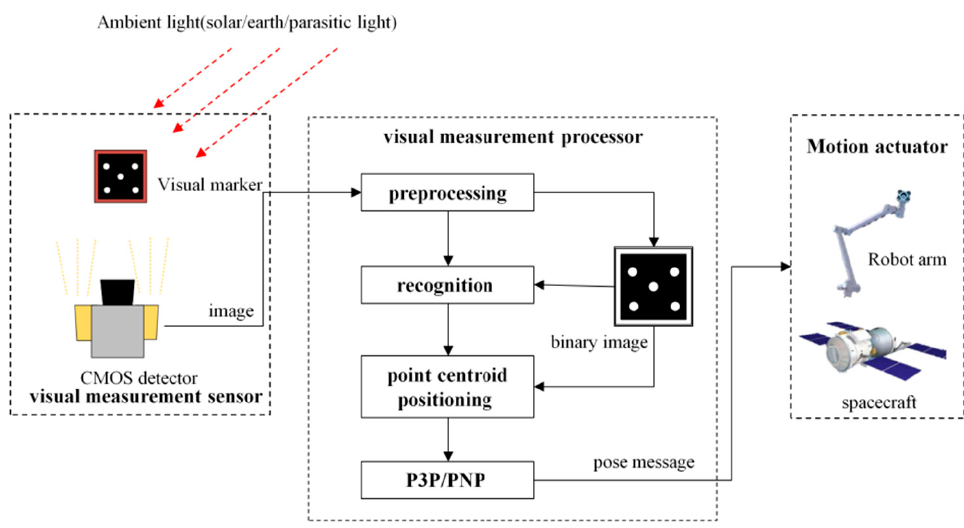
Figure 1. Visual measurement system working frame.